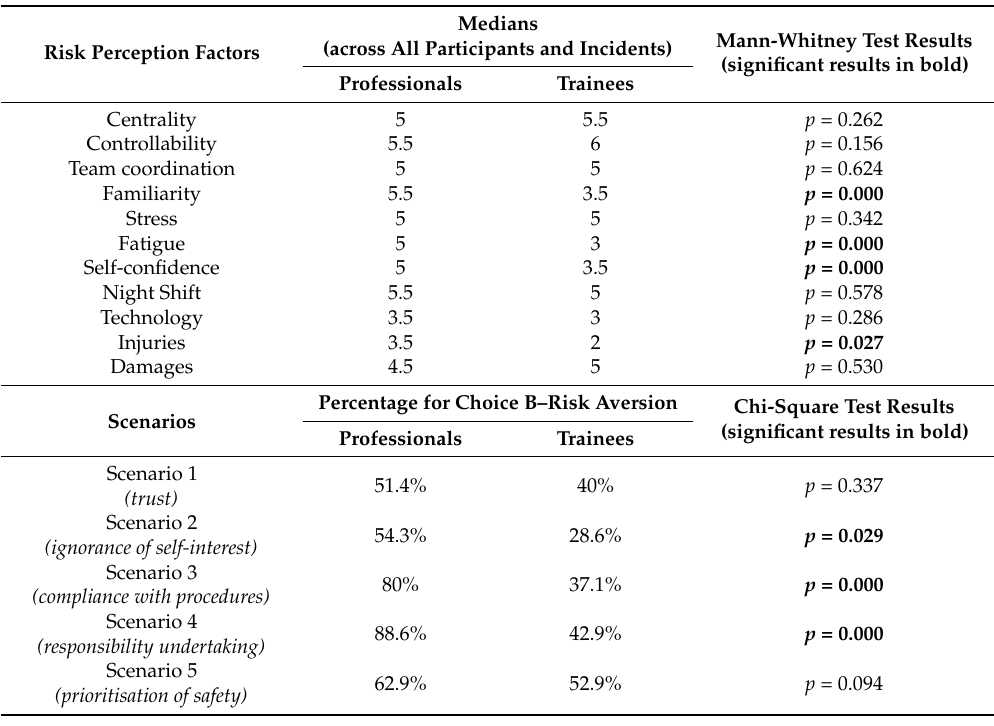
Table 3. Differences between Professionals and